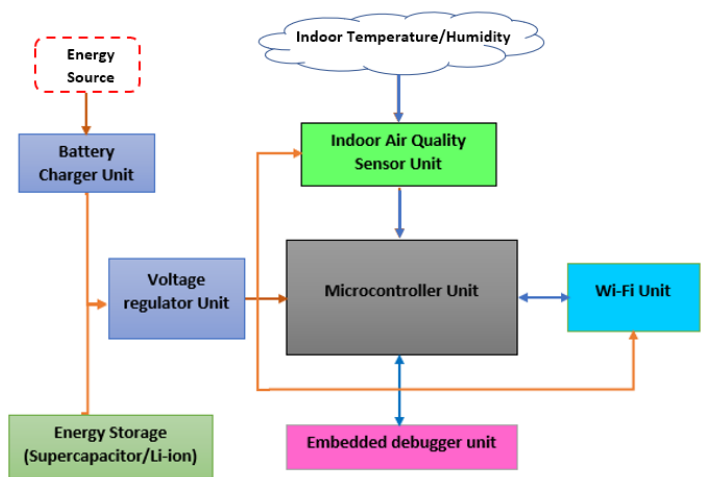
Figure 4. Wireless climate sensor node architecture.